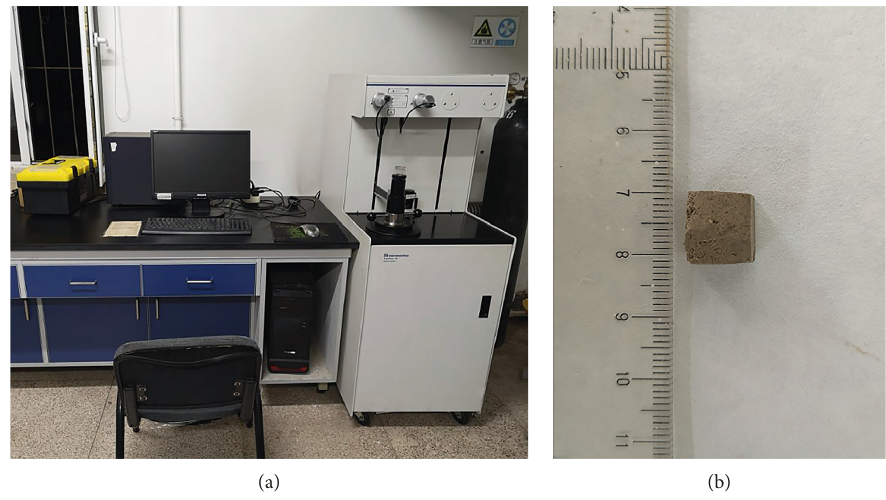
Figure 3: Picture of the mercury injection apparatus and a prepared soil sample for MIP test.